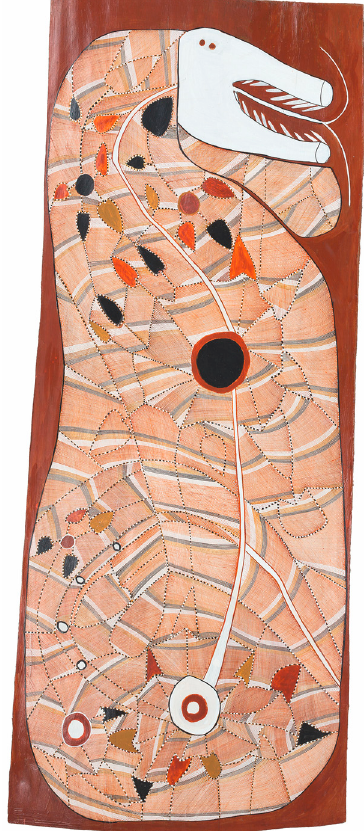
Figure 3. John Mawurndjul, Ngalyod 2012, Museum of Contemporary Art, purchased with funds provided by the MCA Foundation, 2015 © John Mawurndjul/Copyright Agency, 2018, photograph Jessica Maurer.